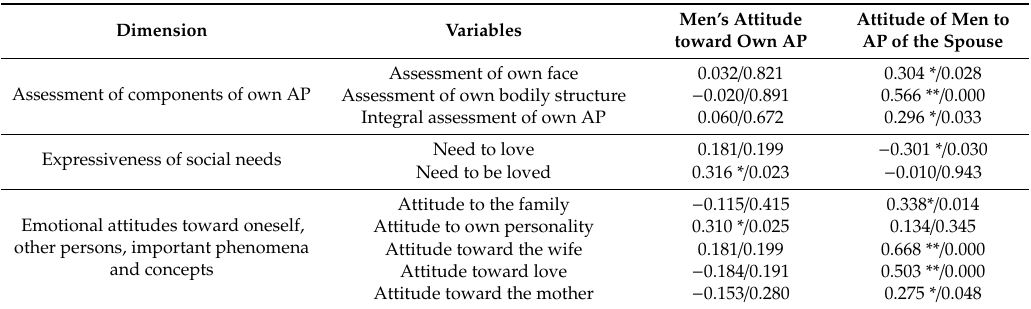
Table 2. Significant correlation relationships of men’s attitudes to their AP and AP of the spouse with their attitude toward themselves, other persons, and the